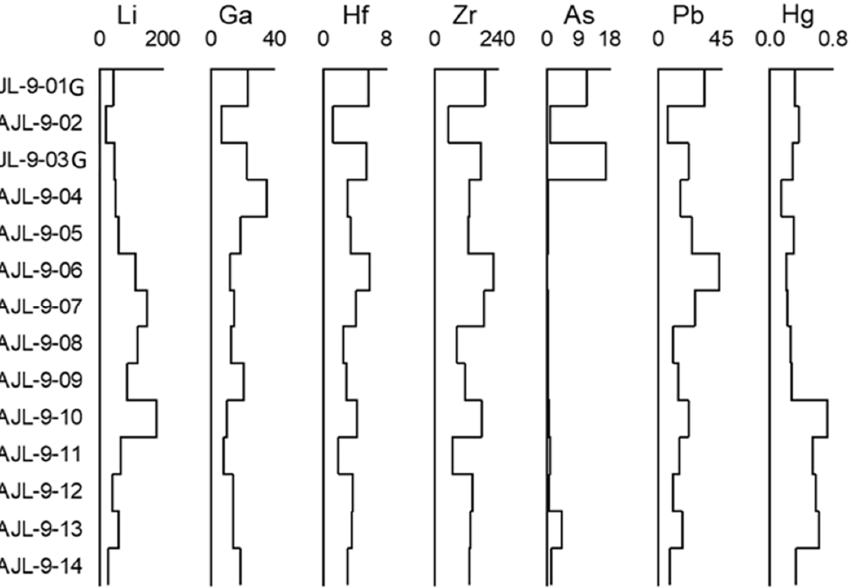
Figure 6. The vertical distribution of selected trace elements in the coal from the Anjialing coal seam 9.